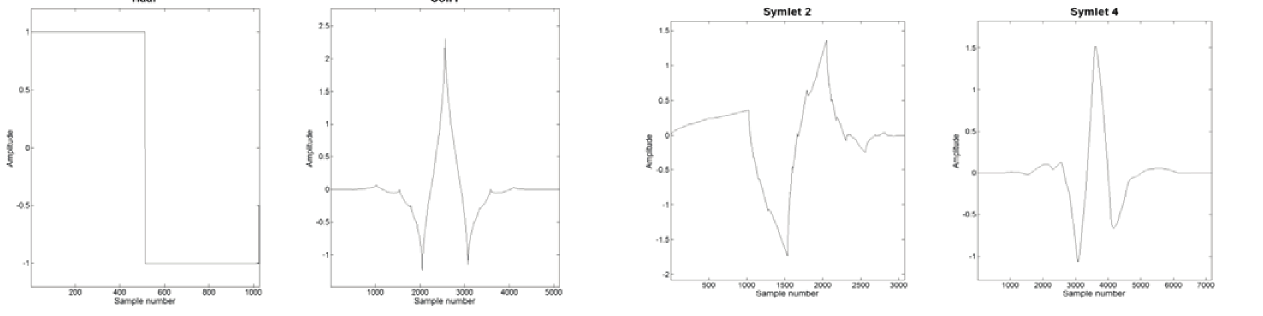
Fig. 7. Haar and Coiflet 1 mother wavelets